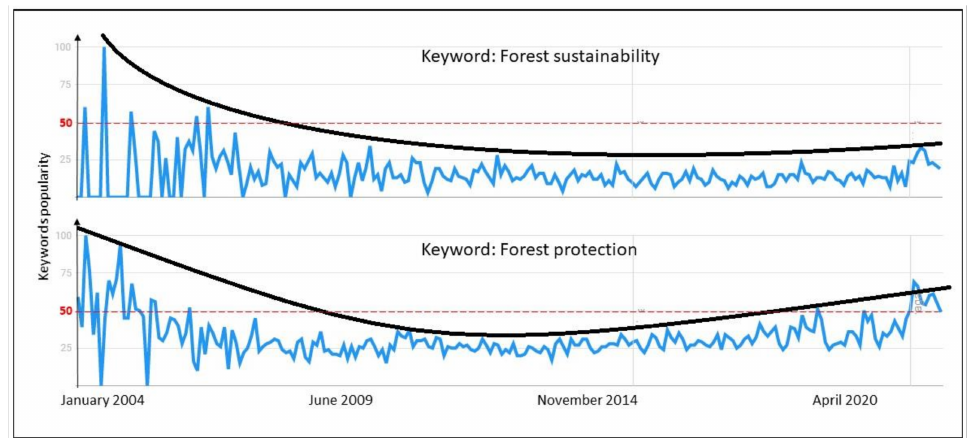
Figure 6. Trends in social interest concerning forest protection and sustainability since 2004, indicated by Google